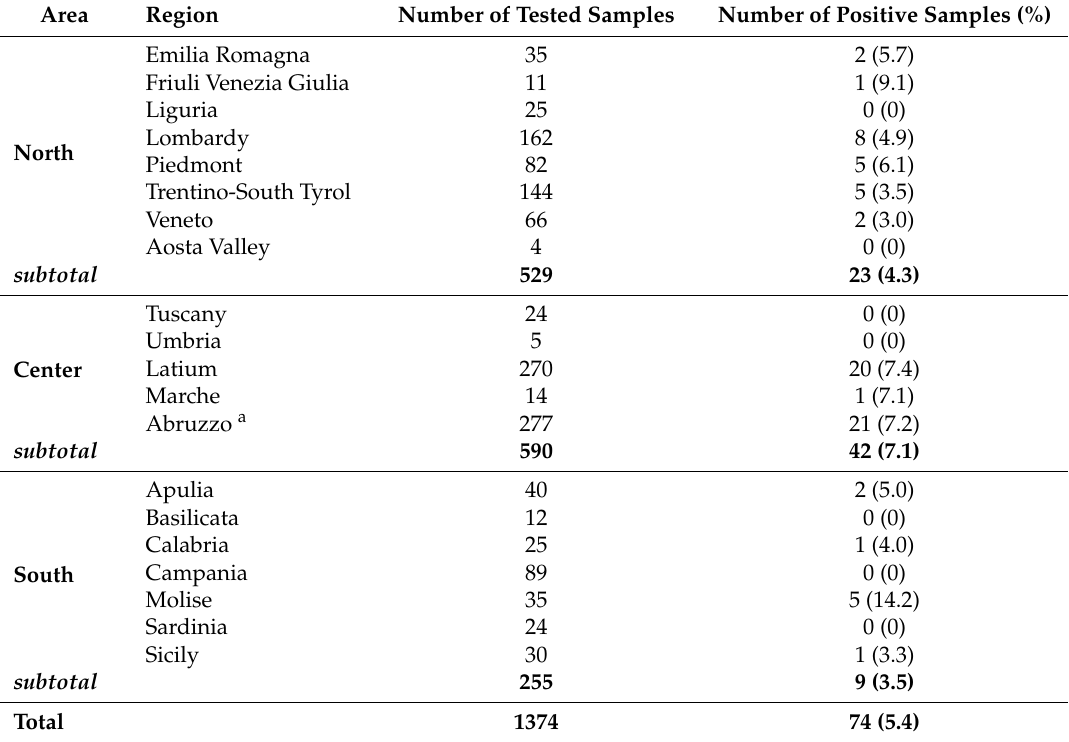
Table 1. Nested RT-PCR results according to Region and geographic area.